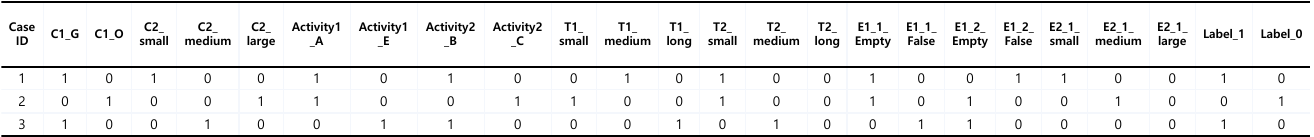
Figure 1. Example of pre-processing an event